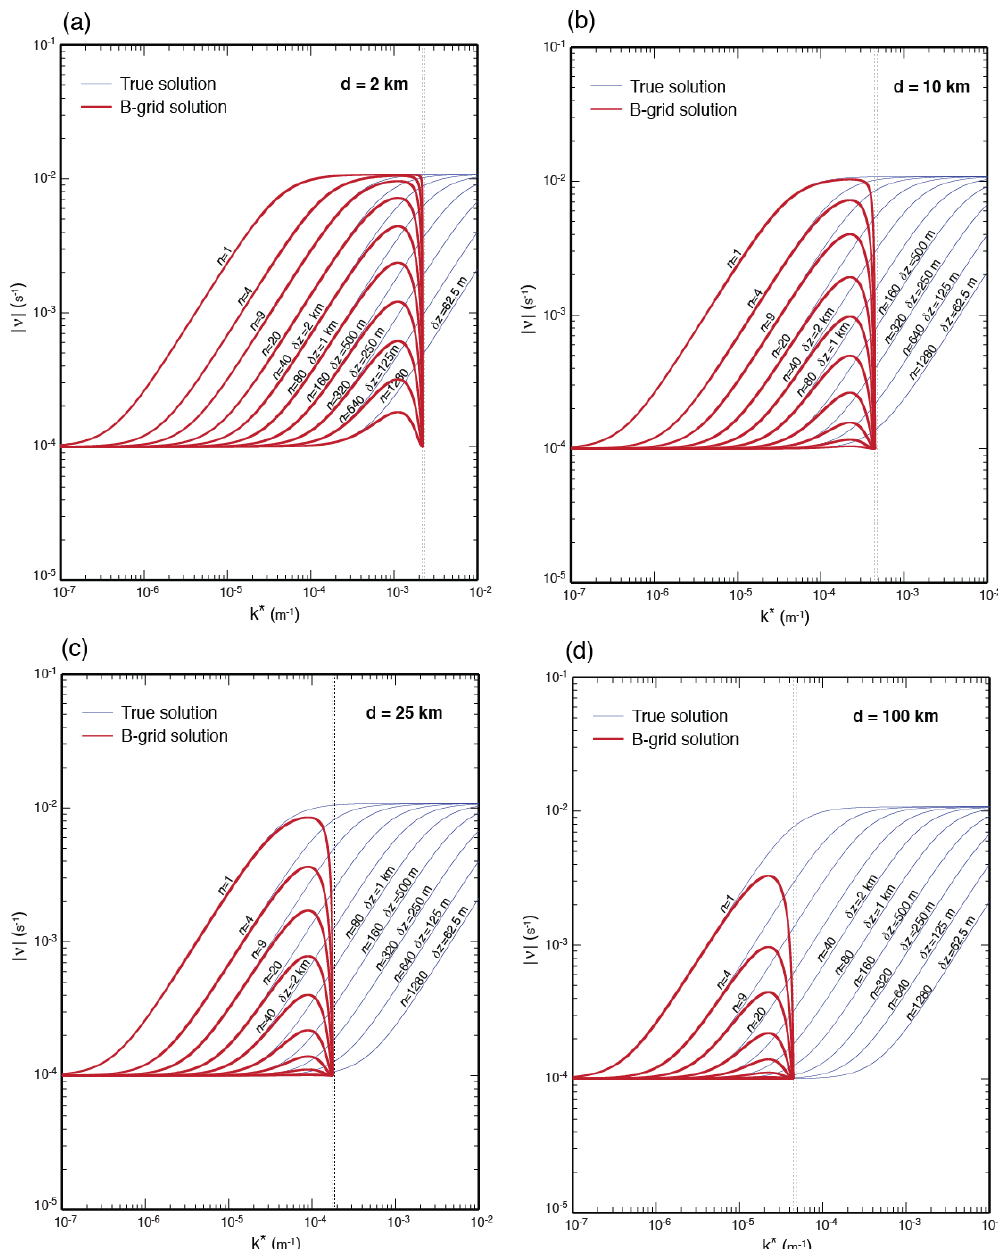
Figure 9. Same as Fig. 2 but for the B